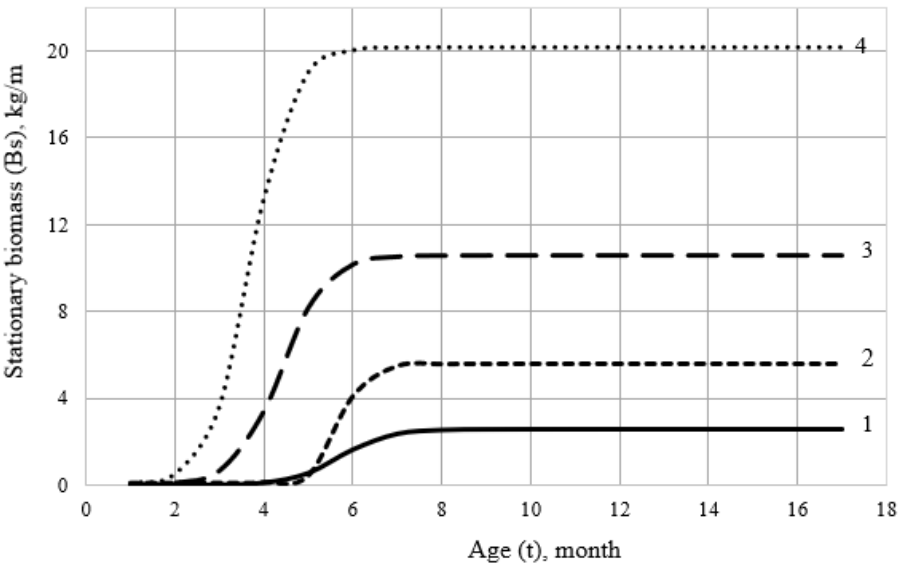
Figure 5. Theoretical curves of changes in stationary mussel biomass (B) ((based on the Pearl–Verhulst logistic growth model)) depending on the relative surface of the artificial substrate (ω): 1 — (ω = 0.09); 2 — (ω = 0.21); 3 — (ω = 0.34); 4 — (ω = 0.55).